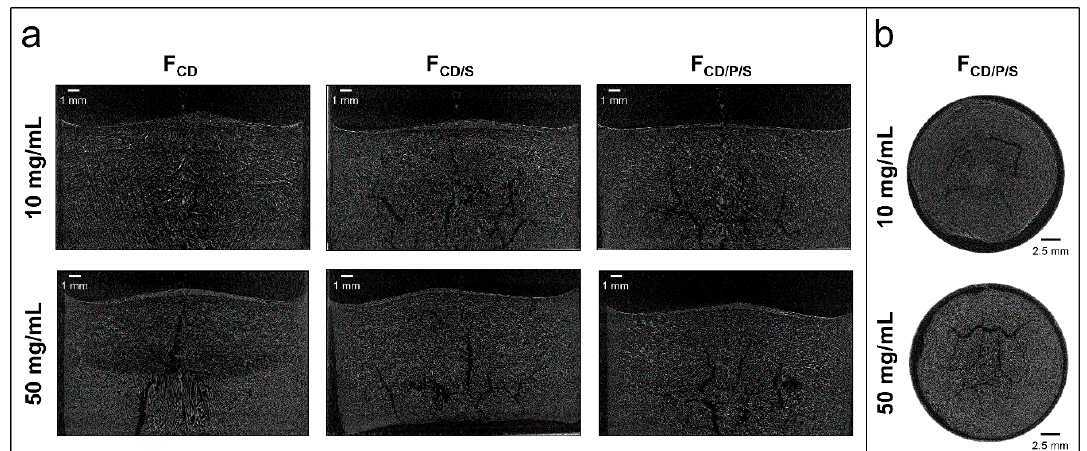
Figure 3. Internal cake structure of F S . Representative micro-computed tomography (µ-CT) images for 10 and 50 mg/mL formulations freeze-dried with different lyophilization cycles.